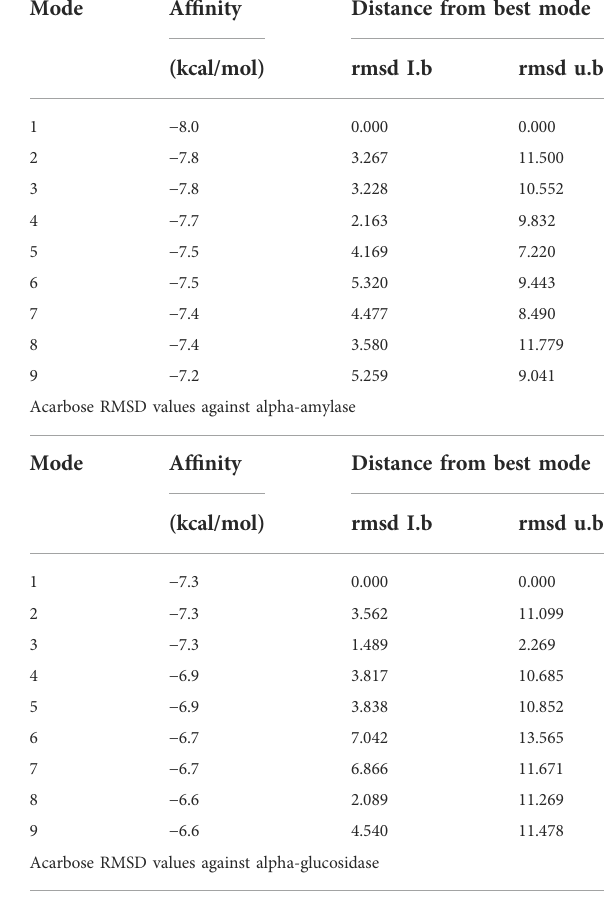
TABLE 4 RMSD values of different poses of standard acarbose drug against α -amylase and α -glucosidase enzymes.